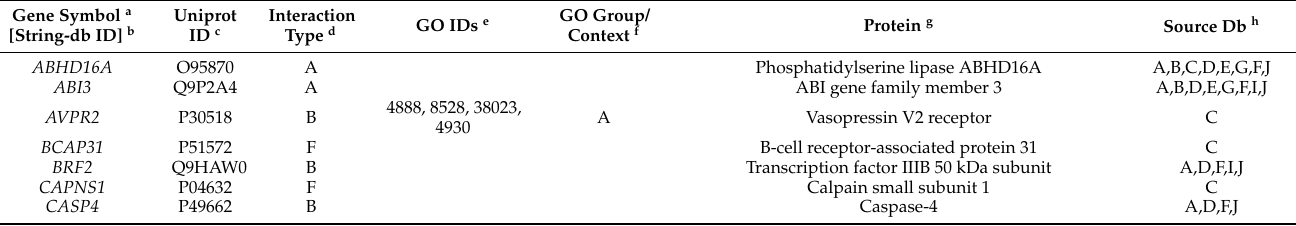
Figure 2. Statistical evaluation of immunofluorescence imaging after RNAi treatment. ( a ) Representative images employed for fluorescence and area quantifications; ( b ) box-and-whisker diagrams of mean fluorescence intensities for DNA, CLIMP63 and RTN4, as indicated; ( c ) bar chart of mean fluorescence intensity (MFI) percentage changes in DNA, CLIMP63 and RTN4 signals for TMEM147 vs. control silencing; ( d ) Bar chart of organelle surface area percentage changes of nucleus (measured as DNA), ER flat cisternae (measured as CLIMP63), ER curved areas (measured as RTN4) and total ER surface area (measured as the overlap-corrected union of CLIMP63 and RTN4 areas) for TMEM147 vs. control silencing; ( e ) bar chart of percentage changes in ER domain ratios, corresponding to ( d ). Error bars indicate the standard deviation of the population. Size markers indicate 20 µ m. **** indicates p < 0.0001. Table 2. Reported TMEM147 associations and interaction. This manually curated, non-redundant list of proteins as retrieved from twelve different repositories is the basis for network and pathway enrichment analyses. The input list of identifiers for String-db and an annotated version of this table are provided as Supplementary Table